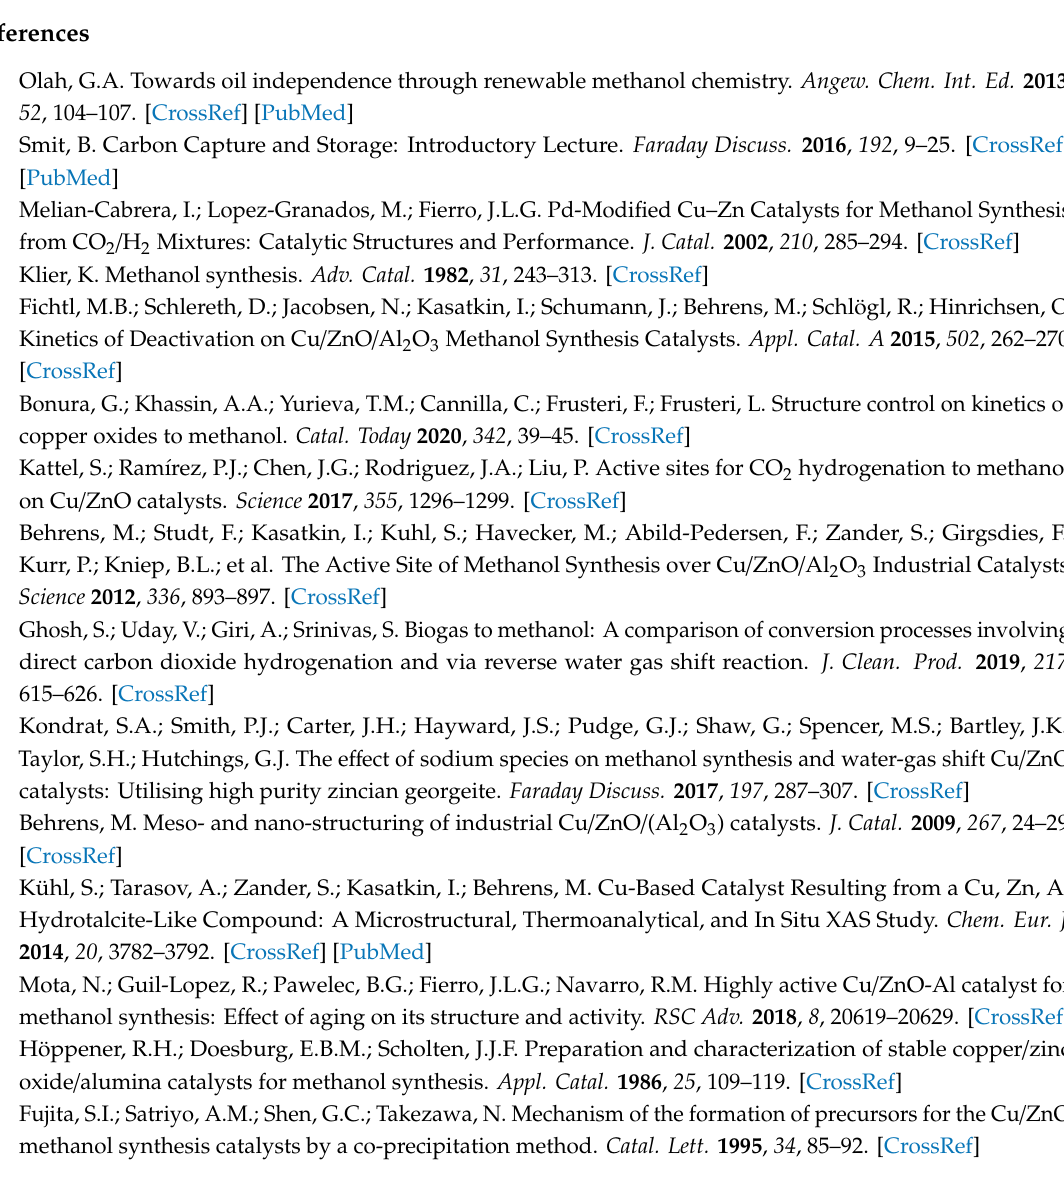
Figure S1: N2 adsorption / desorption isotherms (A) and pore size distribution (B) of the hydroxycarbonate precursors: (a) W / O ( − ), (b) W1 ( − ), (c) W3 ( − ), (d) W6 ( − ), Table S1. E ff ect of Na + and NO 3 − salts (1.8 wt%) on the decarbonation step at high temperature of the W3 hydroxicarbonate